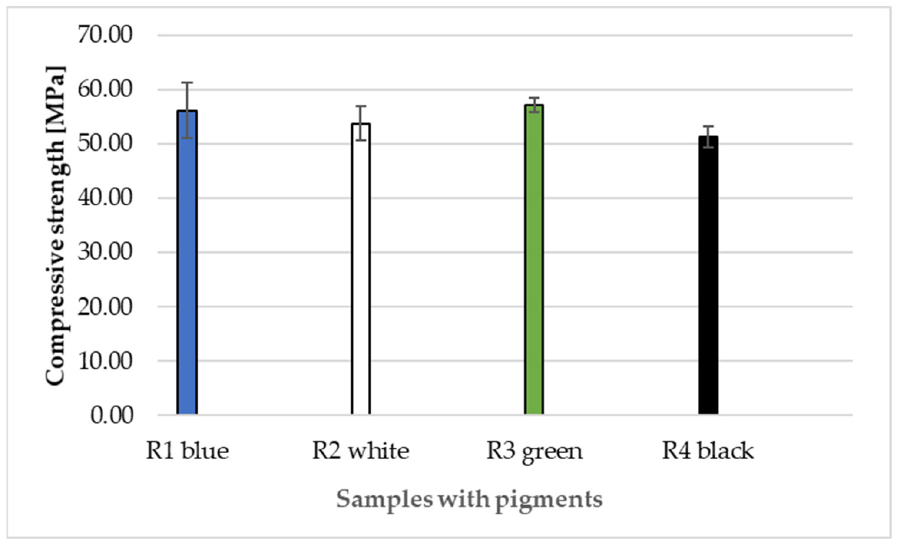
Figure 14. Compressive strengths of composites according to recipes R1–R4 with added pigment.